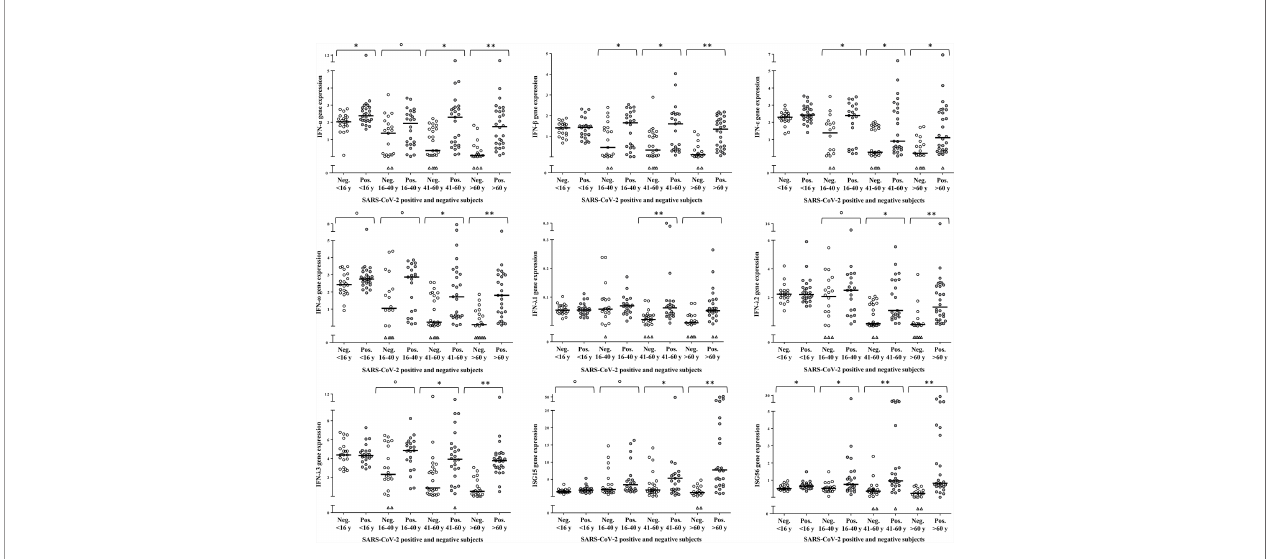
FIGURE 3 | Age-speci fi c activation of IFN genes. Relative mRNA expression values (y-axis), calculated using the threshold cycle relative quanti fi cation (2 - D Ct ), are depicted as open circles for SARS-CoV-2 negative and as fi lled circles for SARS-CoV-2 positive samples, triangles indicate samples with Ct values >40. Horizontal lines represent the median value of the group indicated below the X-axis. P-values, calculated using Mann-Whitney tests for comparison between SARS-CoV-2 negative and positive samples of the same age group, are shown with symbols representing: °0.1<p>0.05, *0.05<p ≥ 0.001,